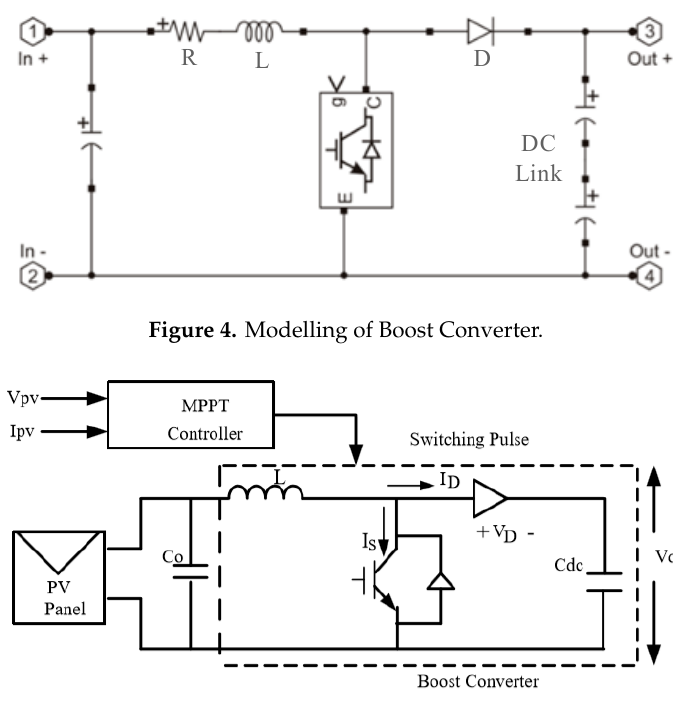
Figure 5. Circuit diagram of the DC-DC Converter with maximum power point tracking (MPPT) Controller.